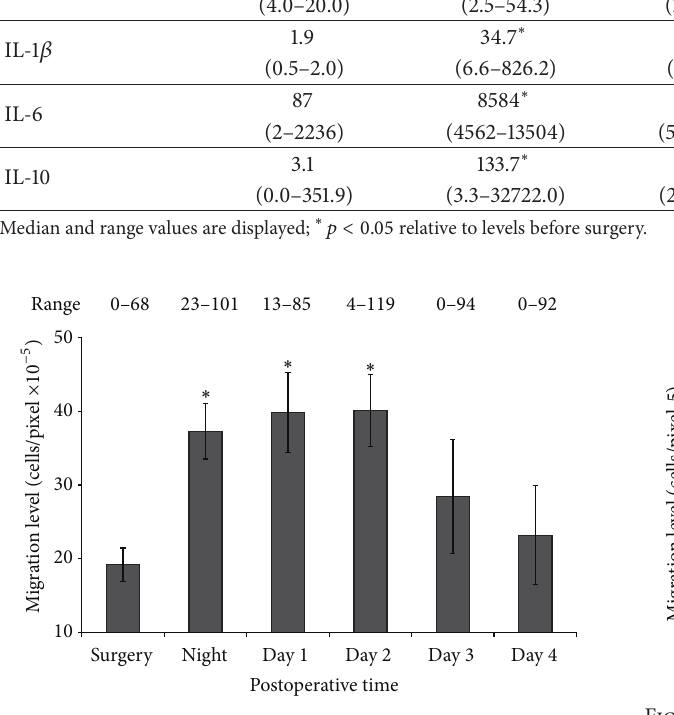
Figure 1: Effect of peritoneal fluids on the migration of colon cancer cells SW480 in vitro . Median values and standard error bars are displayed. ∗ 𝑝 < 0.005 relative to the level before surgery.